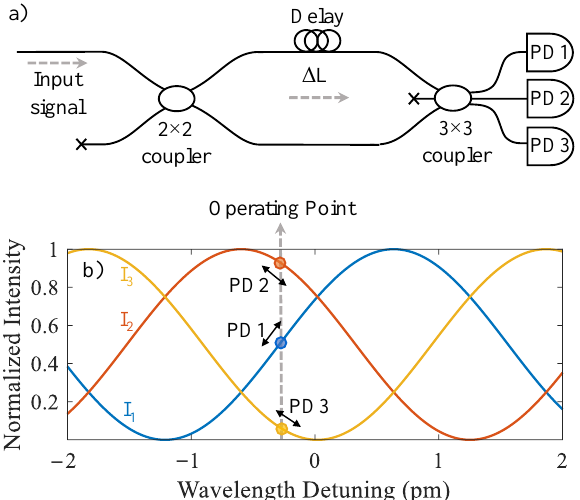
Figure 3. ( a ) Schematic of the MZI filter with a 3 × 3 coupler as the output coupler, and ( b ) transfer function of MZI in terms of the output intensity of the PDs for ∆ L = 65 cm and center wavelength of λ = 1550 nm, and example of the sensor operating